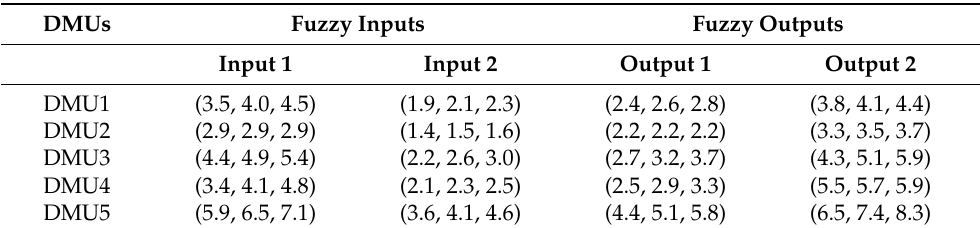
Table 1. Fuzzy input-output data for 5 DMUs (Source: Guo and Tanaka [24]).